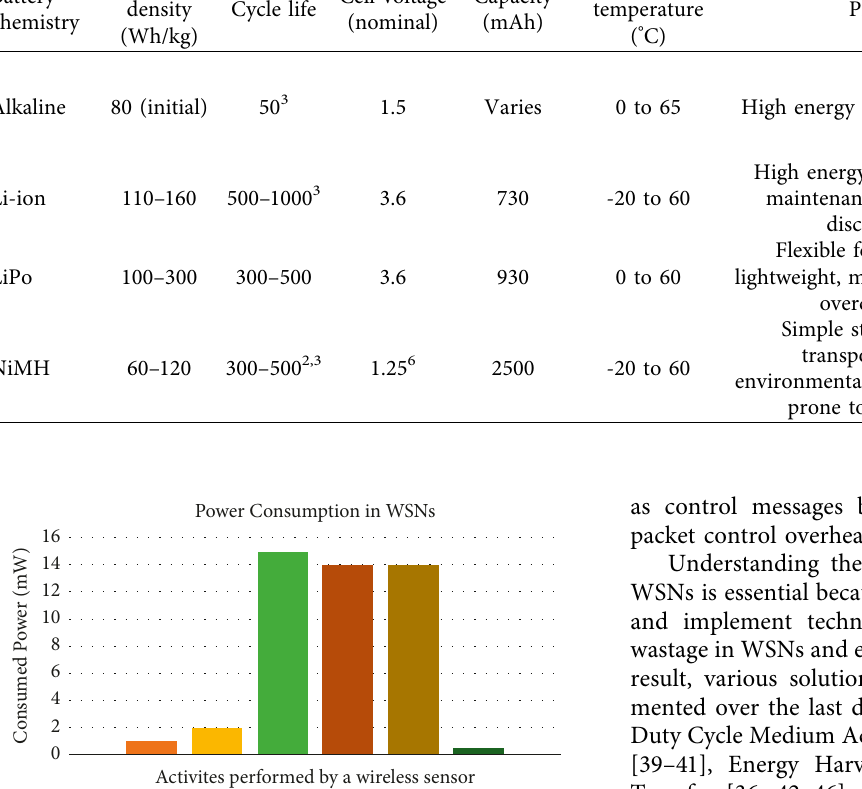
Table 1: Comparison of battery chemistries used in WSNs (adapted from Battery University [30]). Battery